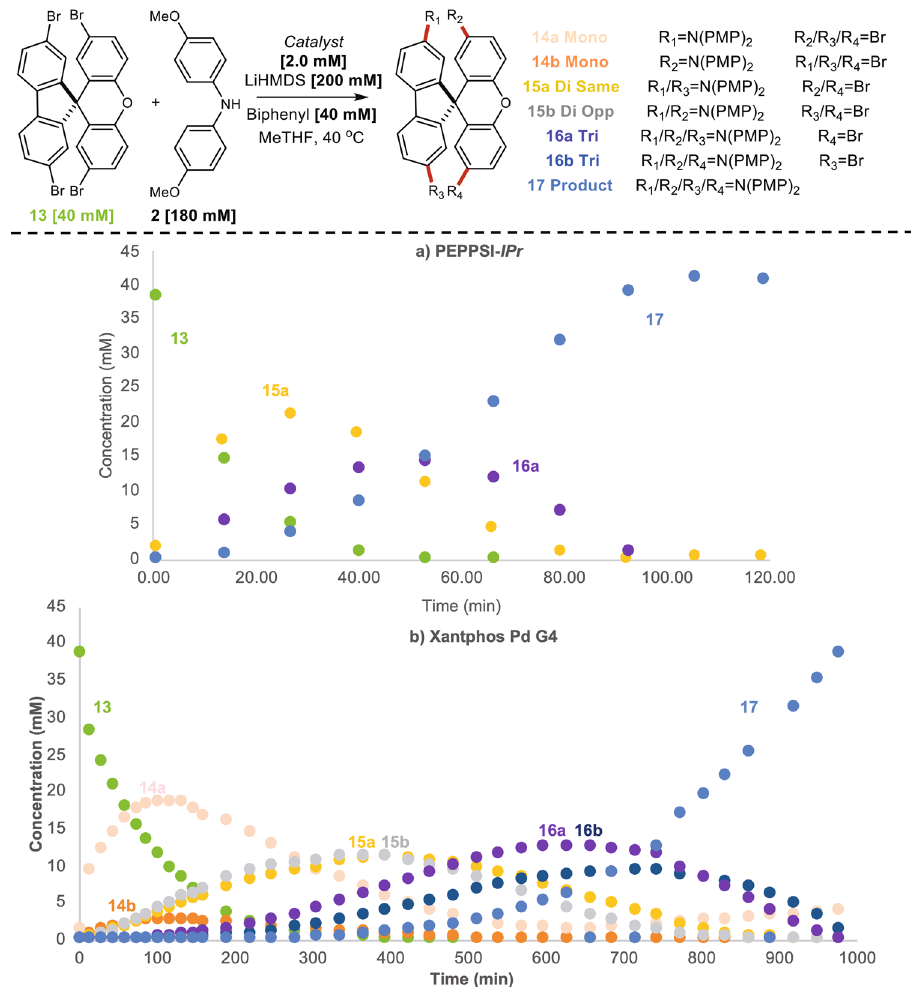
Fig. 9 Time course data on alternative tetrabrominated substrate. a Time course data for coupling of 13 with PEPPSI-IPr. b Time course data for coupling of 13 with Xantphos Pd